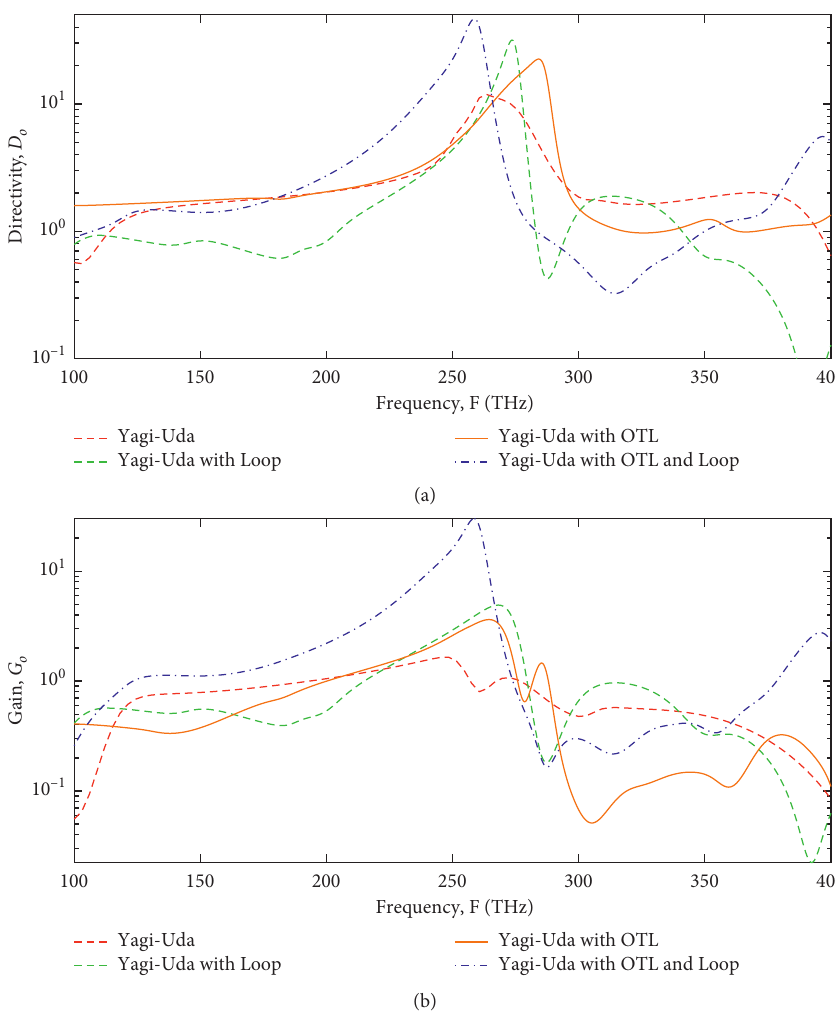
Figure 6: Directivity (D) 0 (a) and gain (G) 0 (b) of the four optimized YU nanoantennas.